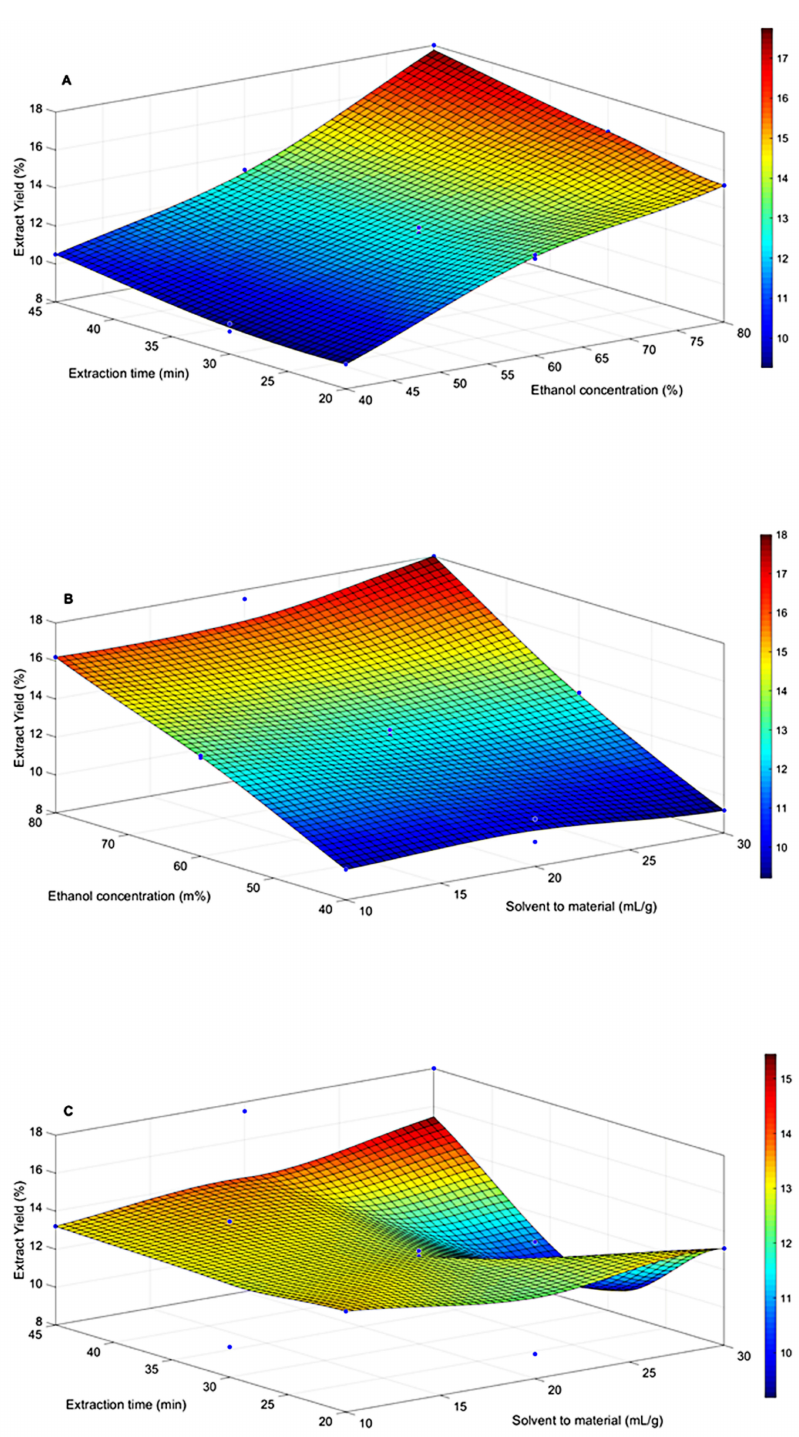
Figure 3. Response surface analysis for the extract yield (%) via ultrasonic extraction (UE) for ( A ) extraction time and ethanol concentration; ( B ) ethanol concentration and solvent-to-material ratio; ( C ) extraction time and solvent-to-material ratio. The data were analyzed using Matlab